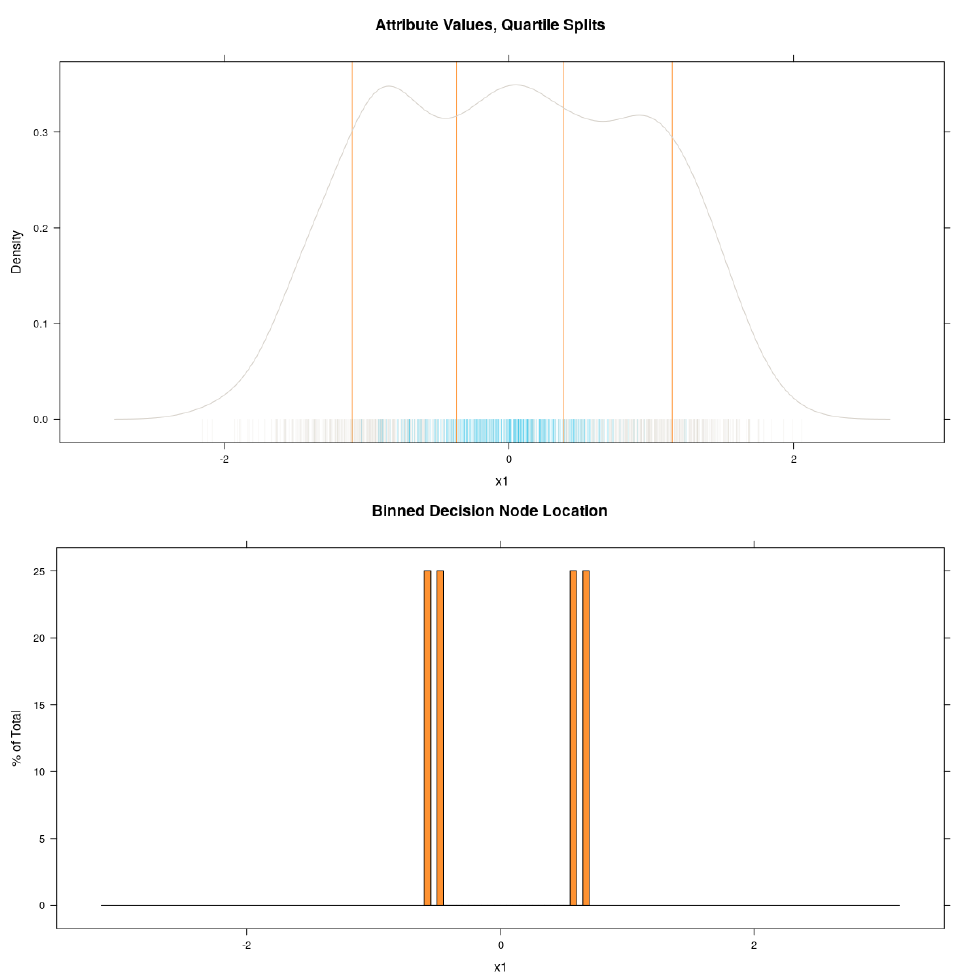
Figure 2. Comparison of preprocessing by quartile binning and postprocessing decision node binning for two non-linearly separable